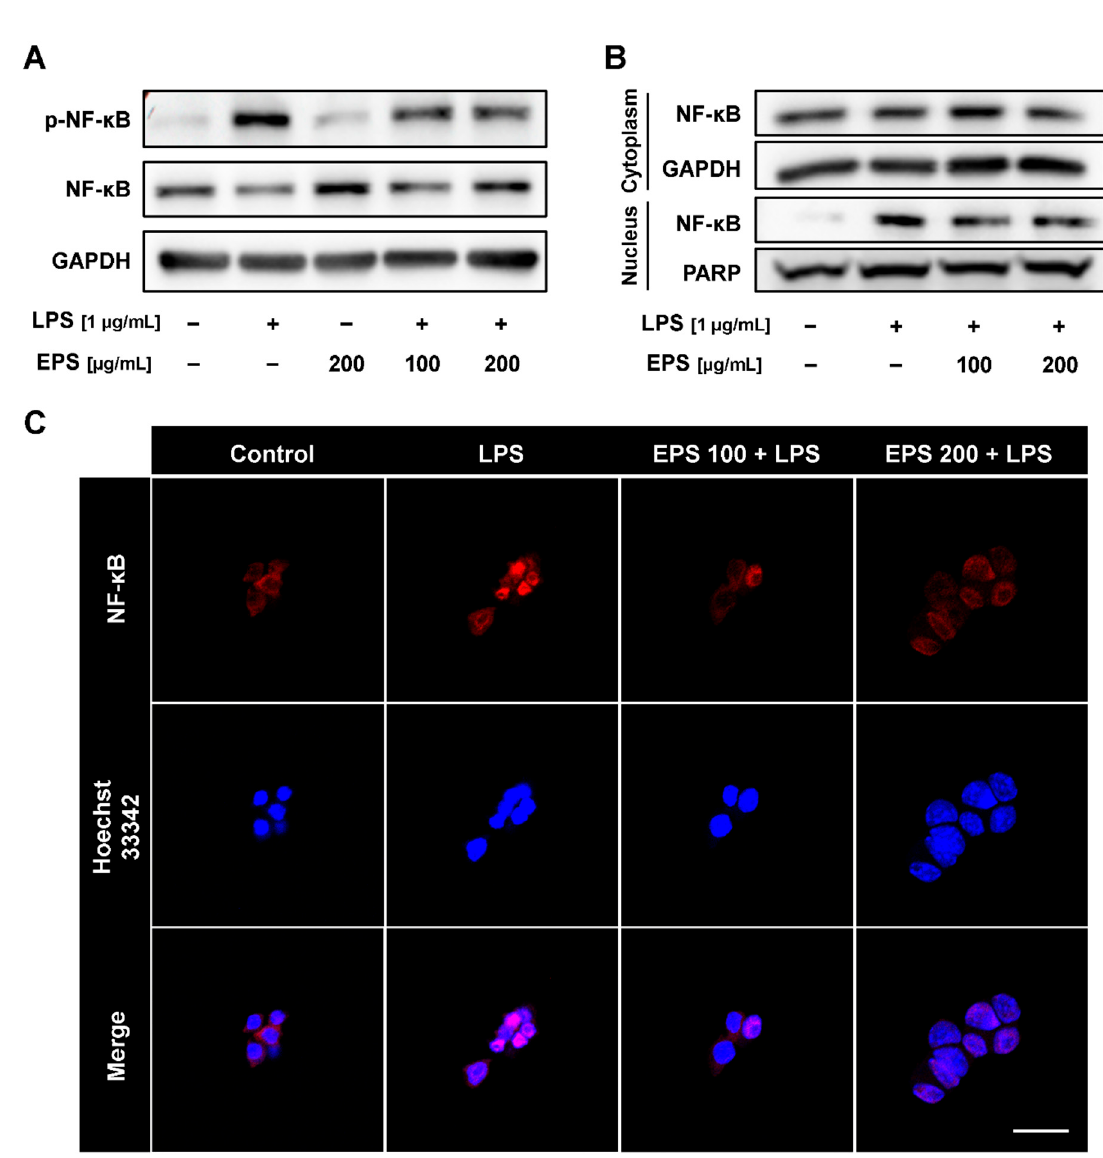
Figure 5. EPS has inhibited the phosphorylation and nuclear translocation of nuclear factor kappa-light-chain-enhancer of activated B cells (NF- κ B) induced by LPS. ( A ) Phosphorylation of NF- κ B was suppressed by EPS in LPS-treated cells as shown via Western blot. ( B ) EPS decreased the translocation of NF- κ B into the nucleus following LPS treatment. ( C ) IF assay also showed that EPS inhibited LPS-induced nuclear translocation of NF- κ B at all tested concentrations. Scale bar = 20 μ m.